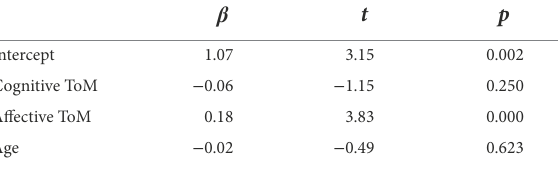
TABLE 6 Results of the multiple linear regression with variety score (response variable) and the cognitive ToM and affective ToM dimensions (independent variables), the covariate being the age